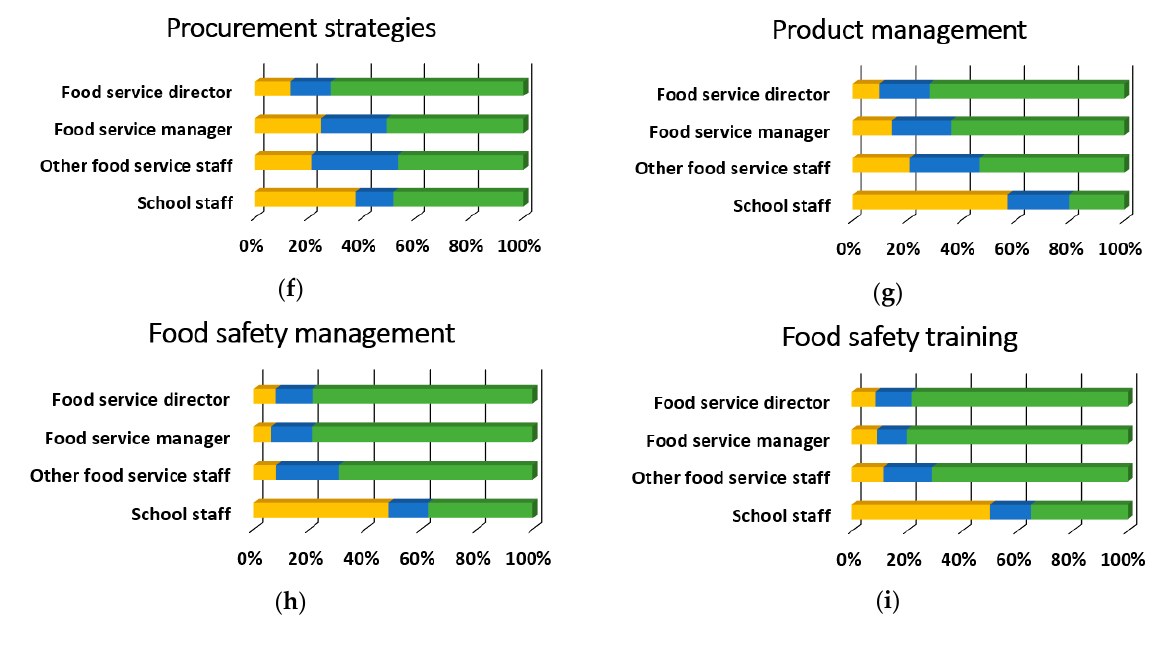
Figure 4. Operations training topic needs that significantly differed by participant role, n = 452 (food service director, n = 152; food service manager, n = 110; other food service staff, n = 62; school staff, n = 128). Described below for each panel are the χ 2 and p -values. ( a ) Standardized recipes, χ 2 (6) = 144.9, p < 0.001, Cramer’s V = 0.40; ( b ) Production records, χ 2 (6) = 121.9, p < 0.001, Cramer’s V = 0.37; ( c ) Meal preparation and cooking skills, χ 2 (6) = 145.7, p < 0.001, Cramer’s V = 0.40; ( d ) Meal pattern crediting documents, χ 2 (6) = 145.9, p < 0.001, Cramer’s V = 0.40; ( e ) Fruit and vegetable bars, χ 2 (6) = 109.3, p < 0.001, Cramer’s V = 0.35; ( f ) Procurement strategies, χ 2 (6) = 36.9, p < 0.001, Cramer’s V = 0.20; ( g ) Product management, χ 2 (6) = 108.8, p < 0.001, Cramer’s V = 0.35; ( h ) Food safety management, χ 2 (6) = 106.7, p < 0.001, Cramer’s V = 0.34; ( i ) Food safety training, χ 2 (6) = 101.0, p < 0.001, Cramer’s V = 0.33.